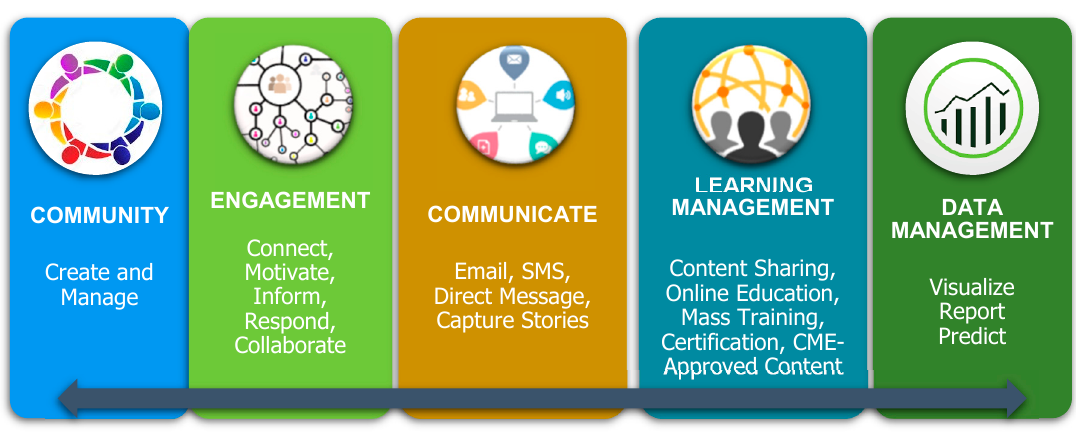
Figure 3. Communication Platform Pillars: The 5 Components of M-ACO Communication Model are Community; Engagement; Communicate; Learning Management; Data Management.